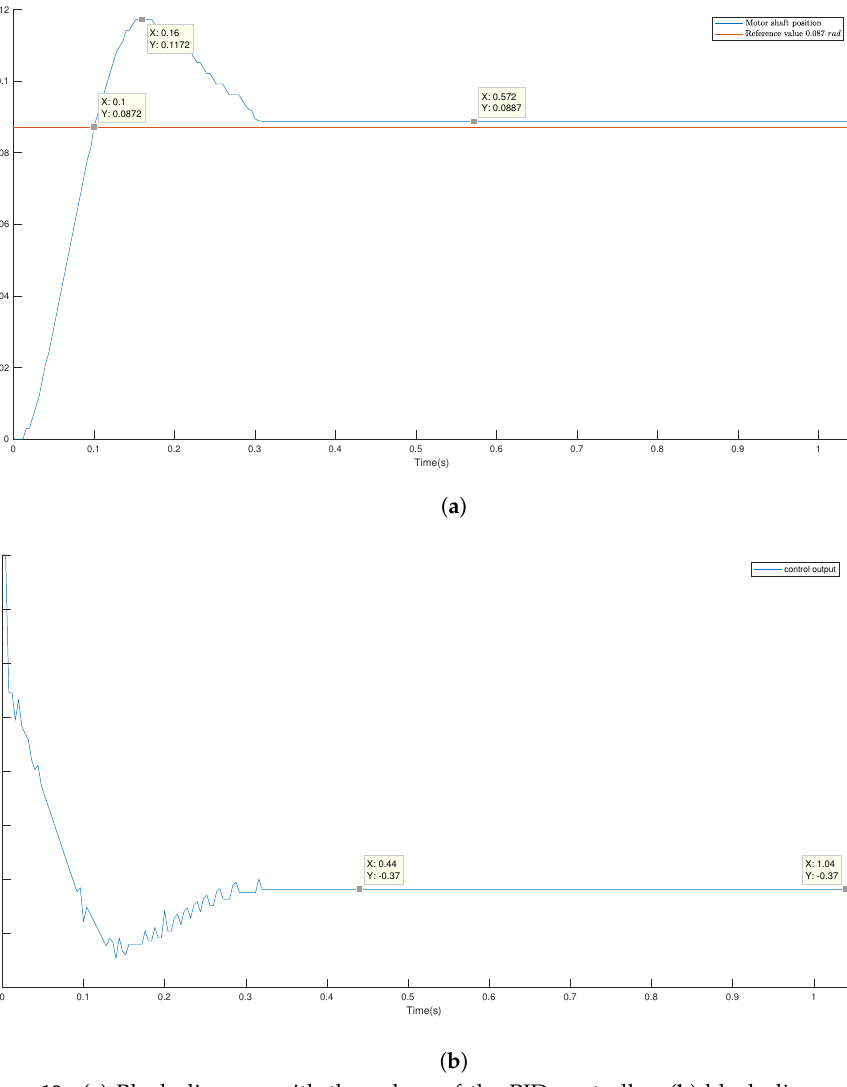
Figure 19. ( a ) Block diagram with the values of the PID controller; ( b ) block diagram after the reduction in the block